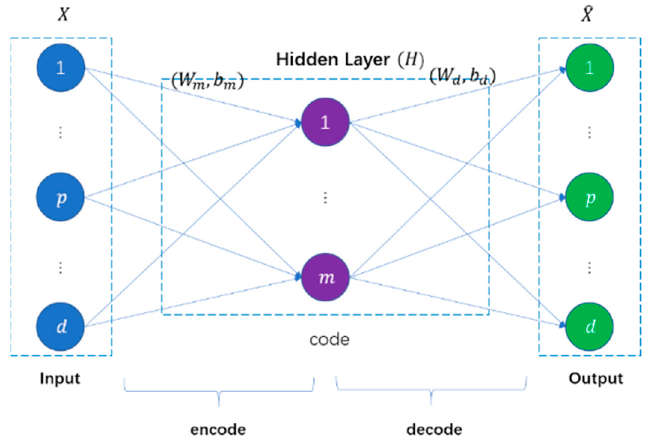
Figure 3. Auto-encoder structure.